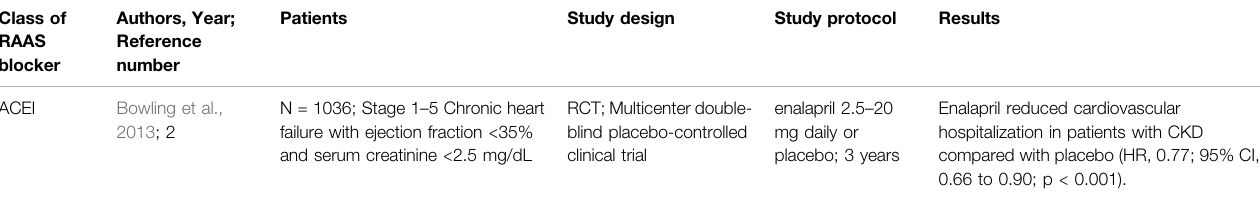
TABLE 3 | Effects of angiotensin converting enzyme inhibitors on the development of cardiovascular disease in pre-dialysis patients with CKD. Class of RAAS